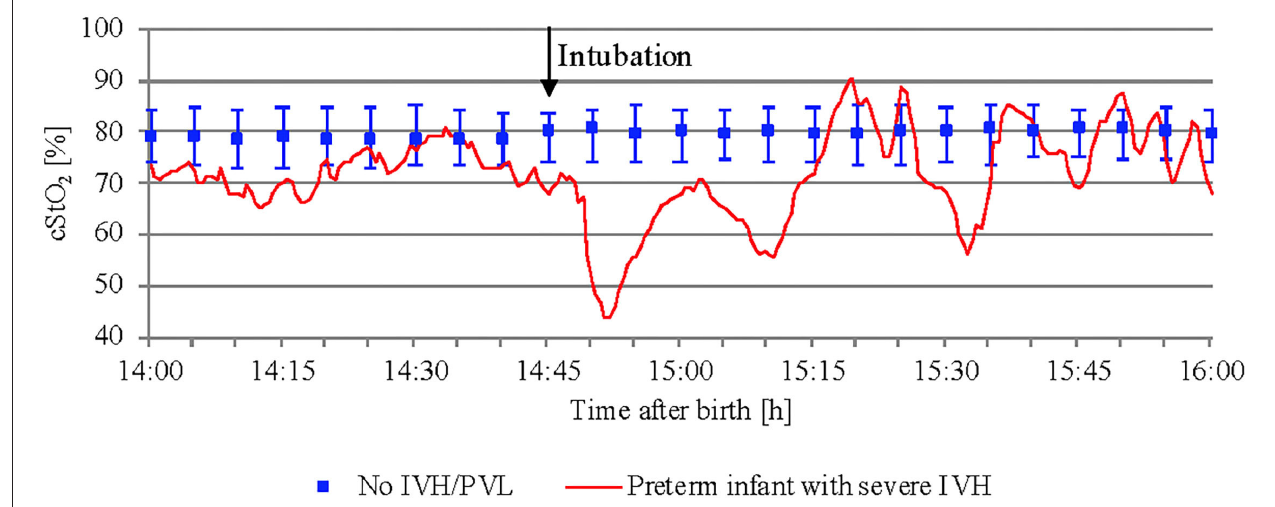
FIGURE 5 | Critical event with cStO 2 < 60% in a preterm infant with severe IVH after intubation. In addition, preterm infants without IVH/PVL are presented (median and interquartile range).